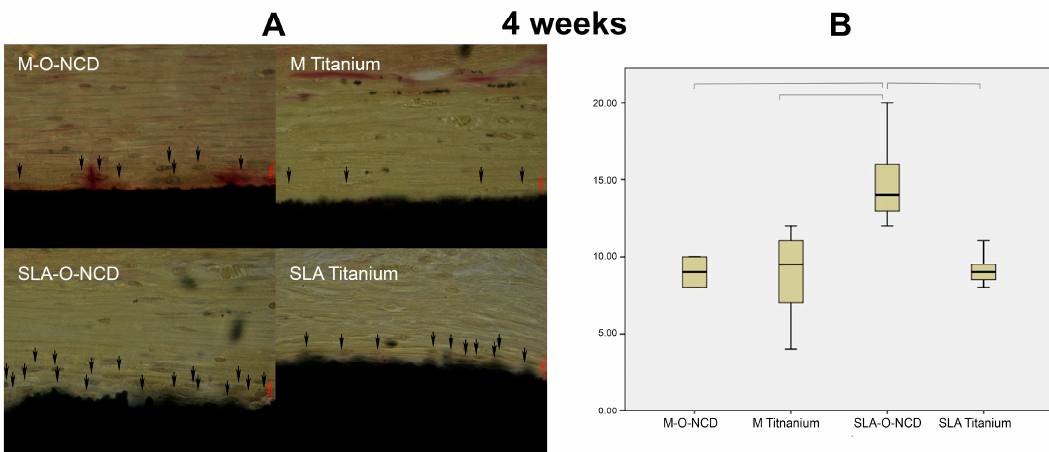
Figure 3 . Van Giesson staining ( A ) revealed most cells in proximity to the rough hydrophilic nano-crystalline diamond coated surface. The red scale bar indicates a 10 µm distance. Boxplot ( B ) shows the descriptive values, and also highlights significant differences through bars.